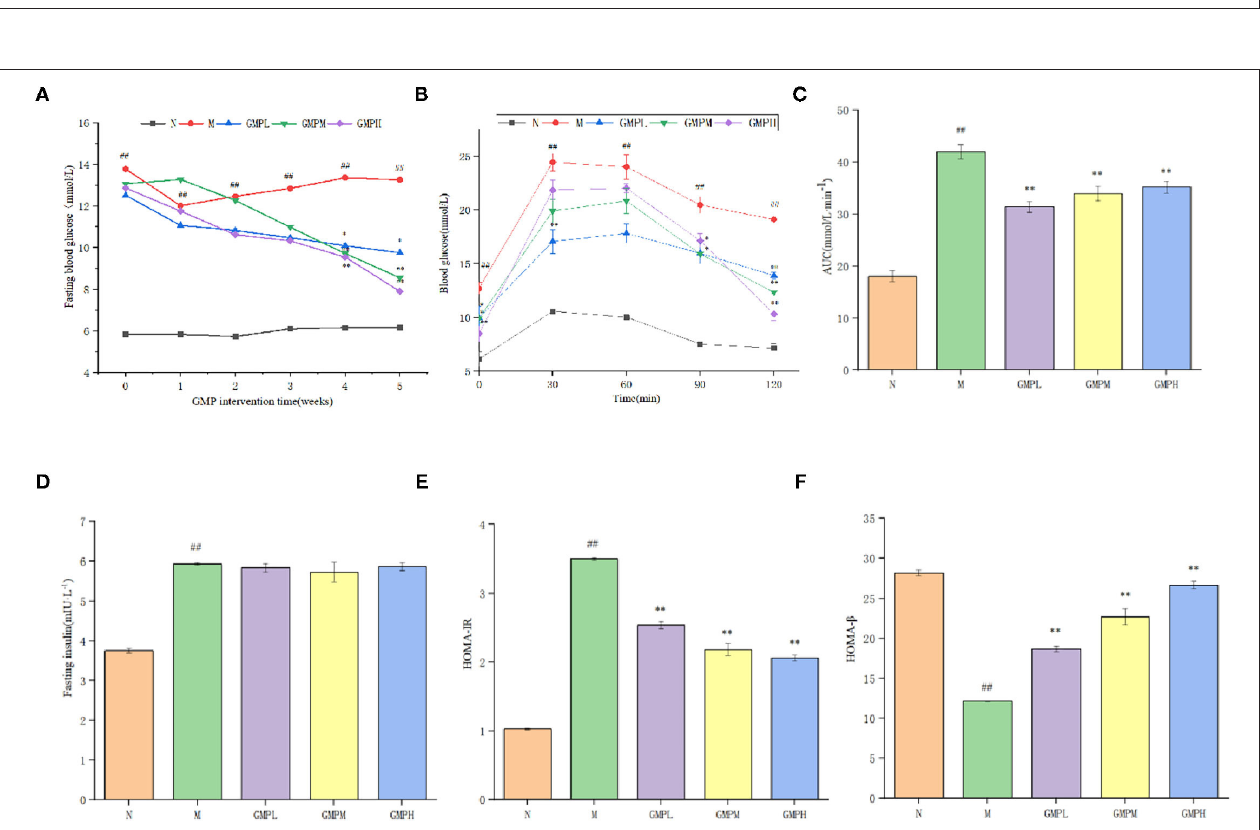
FIGURE 2 | Effects of different doses of GMP on (A) fasting blood glucose levels. (B) Oral glucose tolerance. (C) Blood glucose area under curve. (D) Fasting serum insulin levels. (E) HOMA-IR. (F) HOMA- β . The data in the figure are expressed as mean ± SD (n = 6). Significance of difference: *means p < 0.05, **means p < 0.001, compared with group M. ## means p < 0.001, compared with group N. GMP, germinated mung bean polyphenol; HOMA-IR, Homeostasis model assessment insulin resistance index.